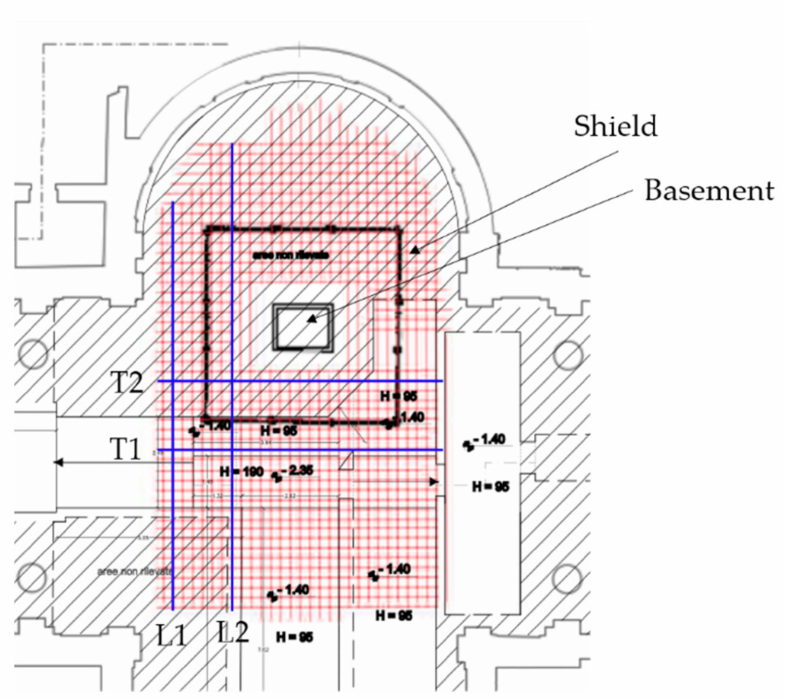
Figure 7. Scan grid composed by 39 longitudinal and 53 transversal scans.